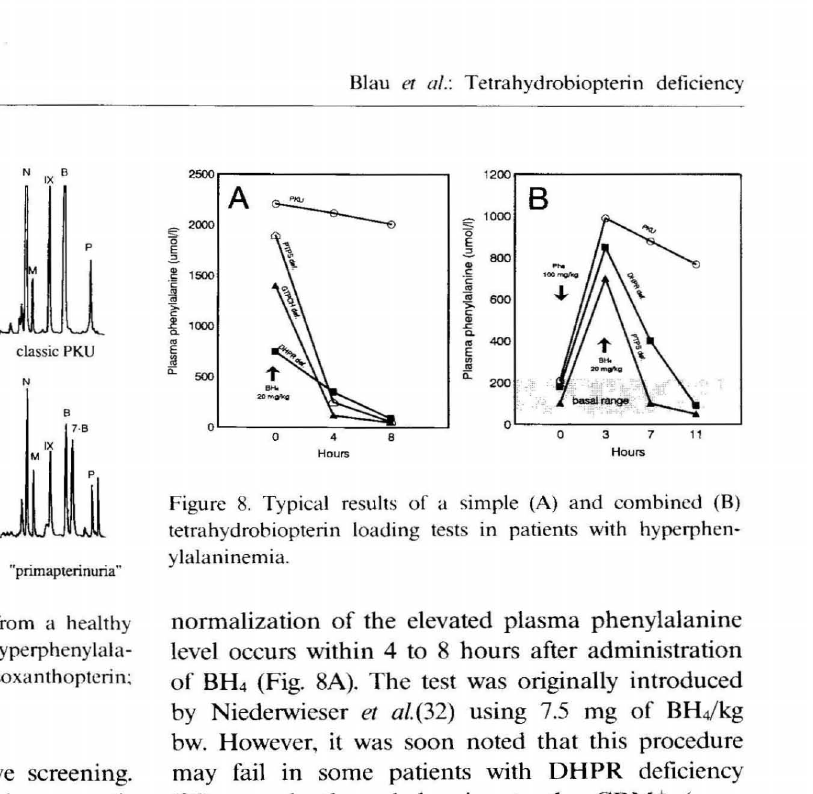
Figure 7. HPLC of urinary pterins (oxidized) from a healthy control and patients with different variants of hyperphenylala ninemia. N: neopterin: M: monapterin; IX: isoxanthopterin: